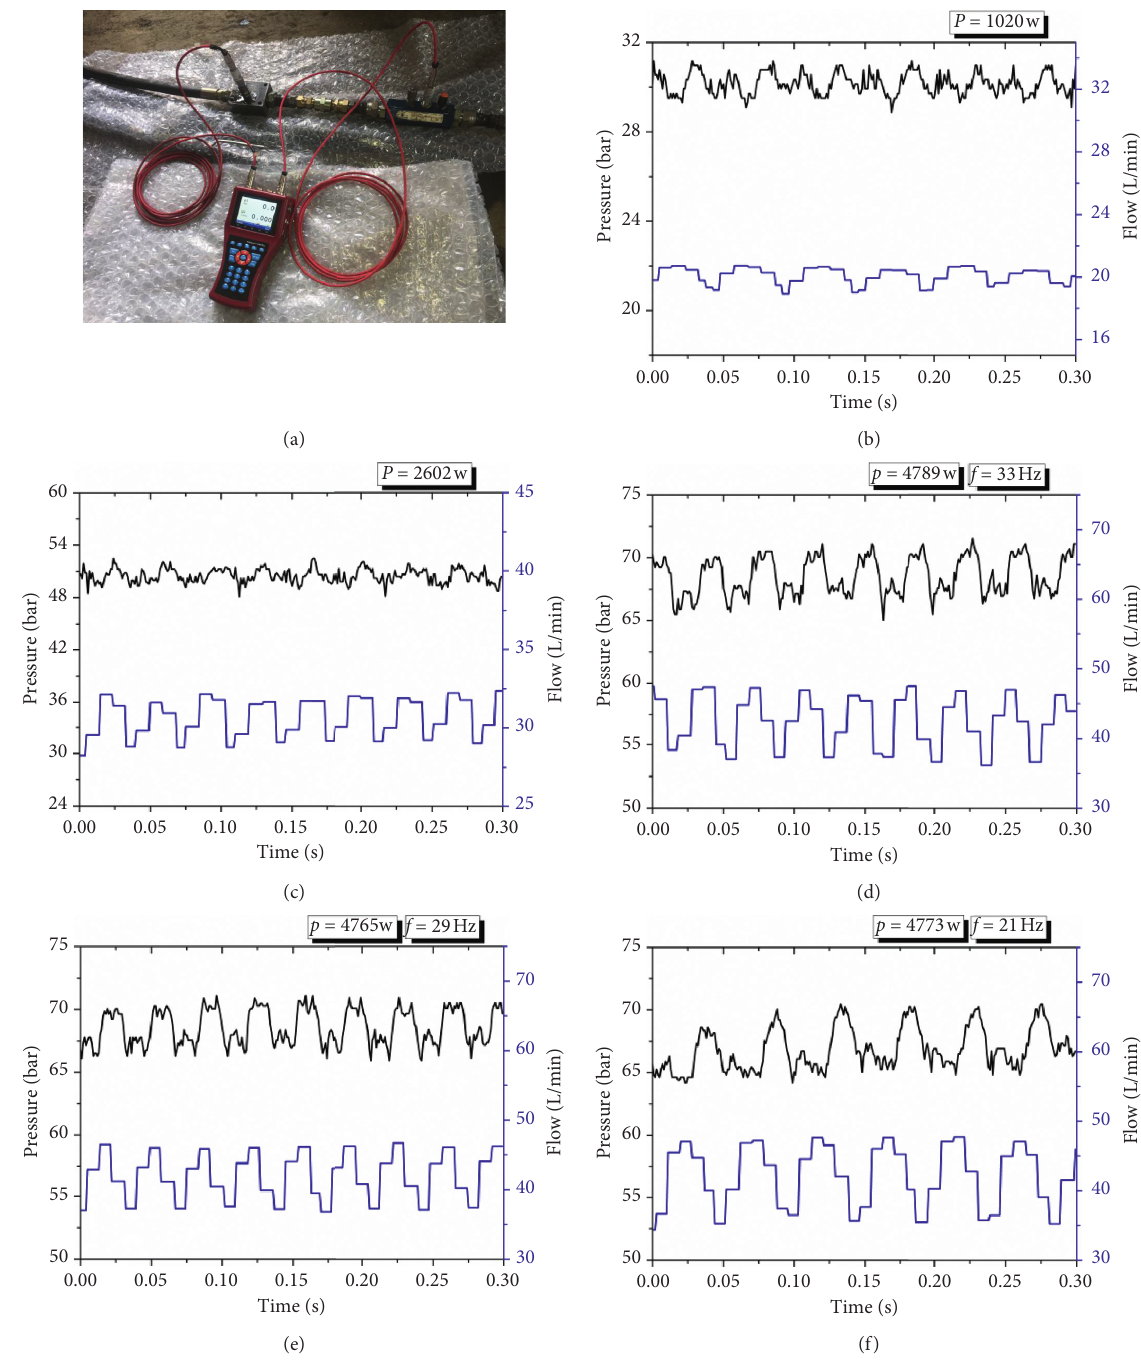
Figure 6: Impact parameters of center hole-drilling applied to each rock block: (a) hand-held Hydrotechnik tester; and impact parameters for (b) rock block A; (c) rock block B; (d) rock block D; (e) rock block C; and (f) rock block